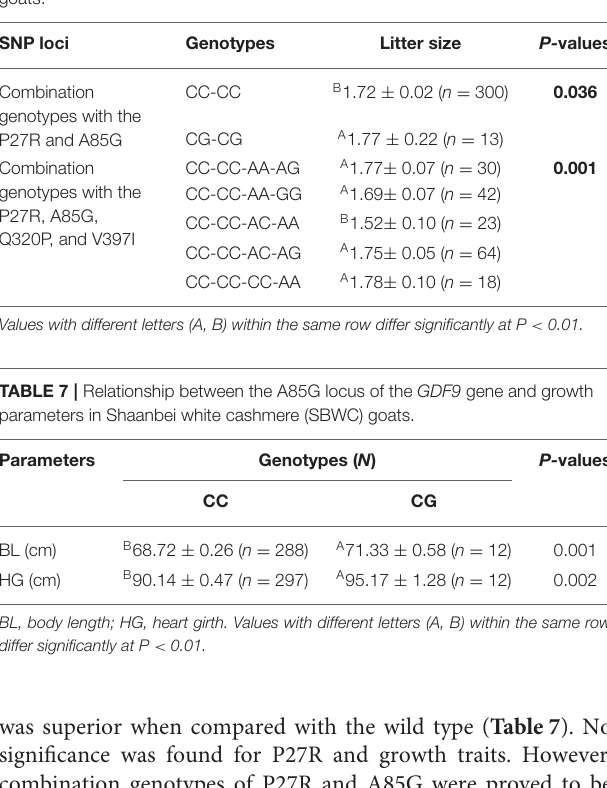
TABLE 6 | Least squares mean and standard error for litter size of different combination genotypes of the GDF9 gene in Shaanbei white cashmere (SBWC) goats.